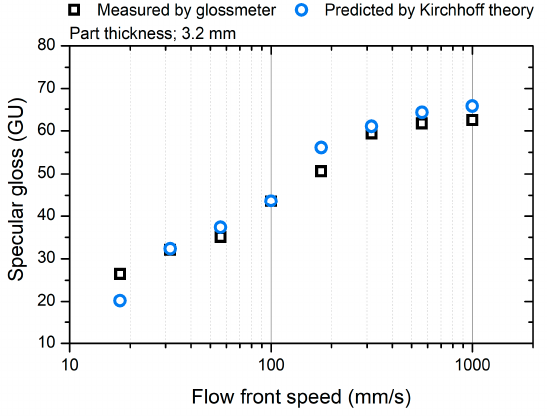
Figure 8. Comparison of the measured and predicted surface gloss.